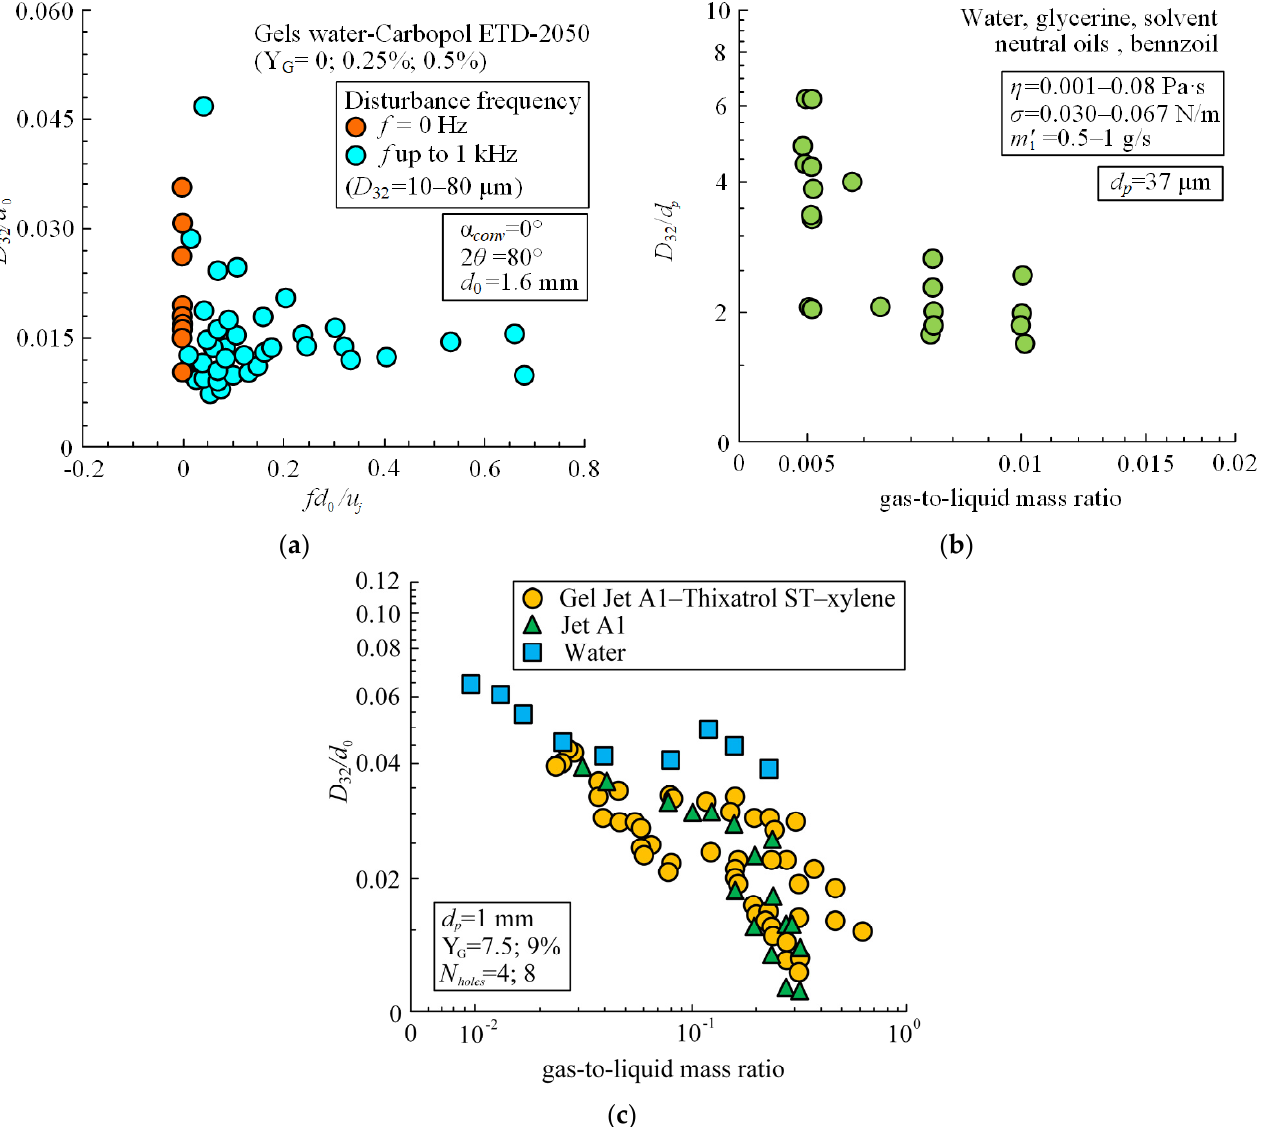
Figure 15. Dimensionless Sauter mean droplet diameters from the parameter of the spraying device ( d 0 / u j ) [69,146,148,149,151,153,168,171,179]